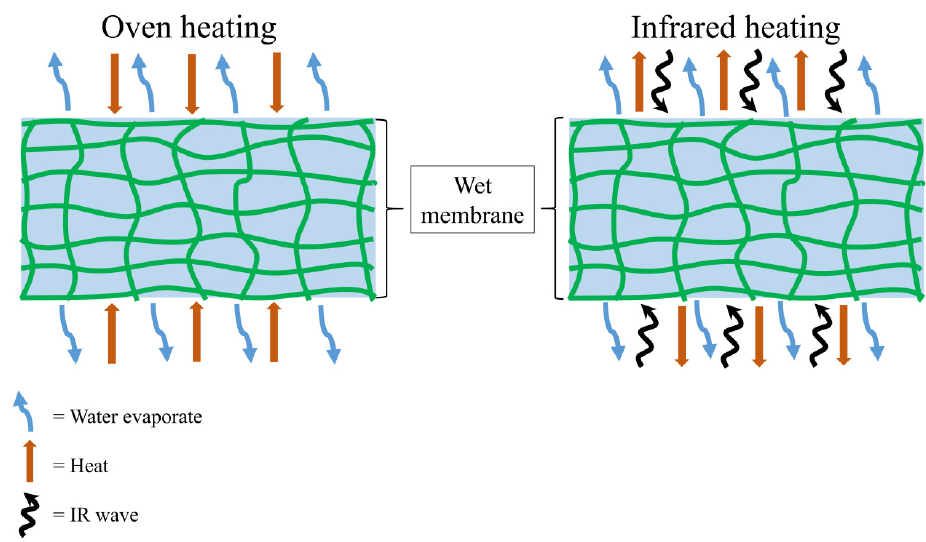
Figure 2. Schematic representation of the heating mechanisms of oven drying and IR drying on RCM.